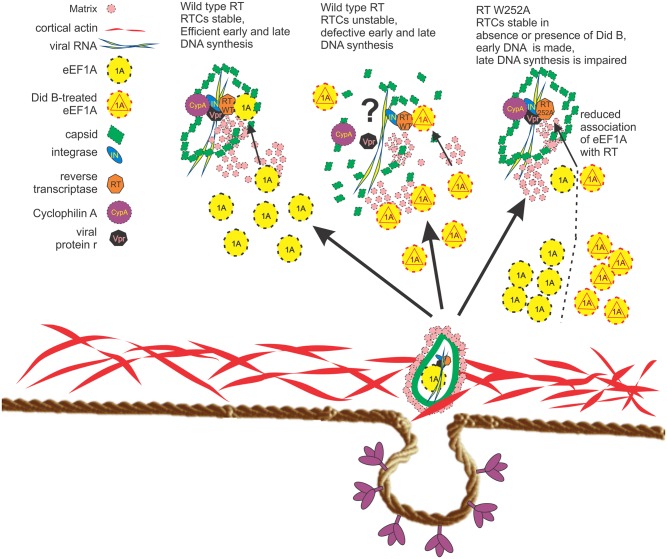
Did B inhibits early HIV-1 replication by targeting the RT-eEF1A interaction.Immediately following fusion of the viral and cellular membrane, the viral core and matrix are released into the cytoplasm. Subsequently the viral core undergoes uncoating and reverse transcription. Here we propose that eEF1A is recruited to the RTC by a direct interaction with RT that increases the efficiency of reverse transcription completion. It is unclear if virion eEF1A [12], target cell eEF1A or both are required. HIV-1 containing a W252A RT mutant has decreased ability to interact with eEF1A. Treating cells with Did B generates pools of eEF1A-Did B as well was RT-eEF1A-DidB complexes. The RT-eEF1A-Did B complex does not support uncoating and reverse transcription and results in decreased RTC levels and reduced DNA synthesis. The status of other RTC protein interactions requires experimental confirmation (as denoted by a “?”). However, a W252A RT mutant HIV-1 is unaffected by Did B because its interaction with eEF1A, or with a eEF1A - Did B complex, is downregulated and catalyzes reverse transcription in either the presence or absence of Did B albeit at reduced efficiency.